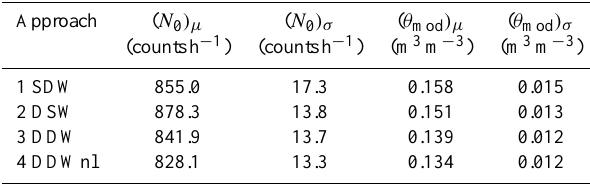
Table 5. Means ( µ ) and standard deviations ( σ ) of calibration pa- rameter N 0 and means ( µ ) and standard deviations ( σ ) of result- ing time series of volumetric soil water content θ mod for the four weighting approaches with 10 calibration campaigns each.